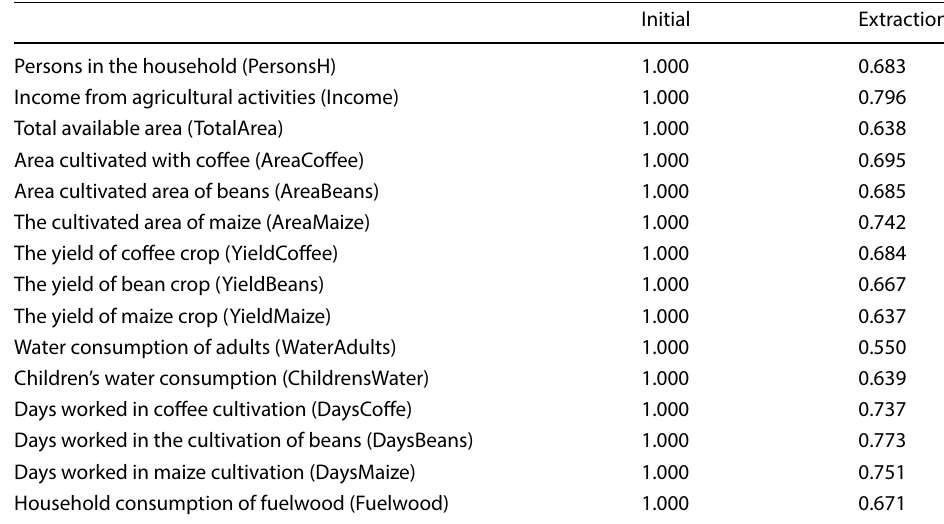
Table 1 Common factors of the variables explain proportional variance